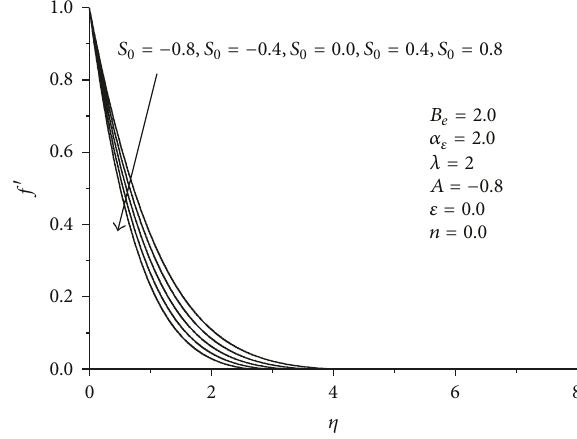
Figure 1: The effect of suction/injection on 𝑓 󸀠 .